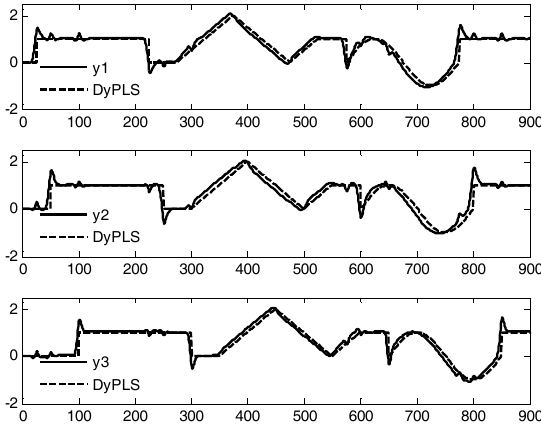
Figure 6. Control results of conventional model predictive control (MPC) in dynamic PLS. Information 2017 , 8 , 121